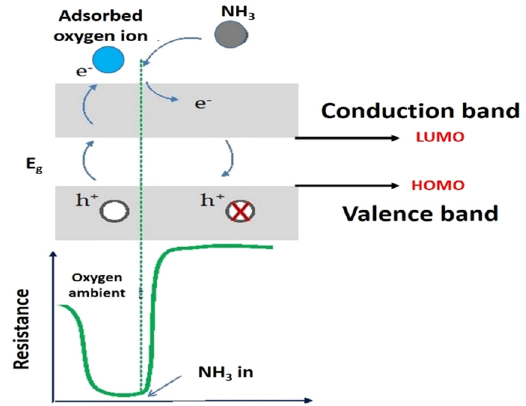
Figure 13: Adsorption phenomenon of NH 3 with increase of resis - tance when the reducing gas like NH 3 is